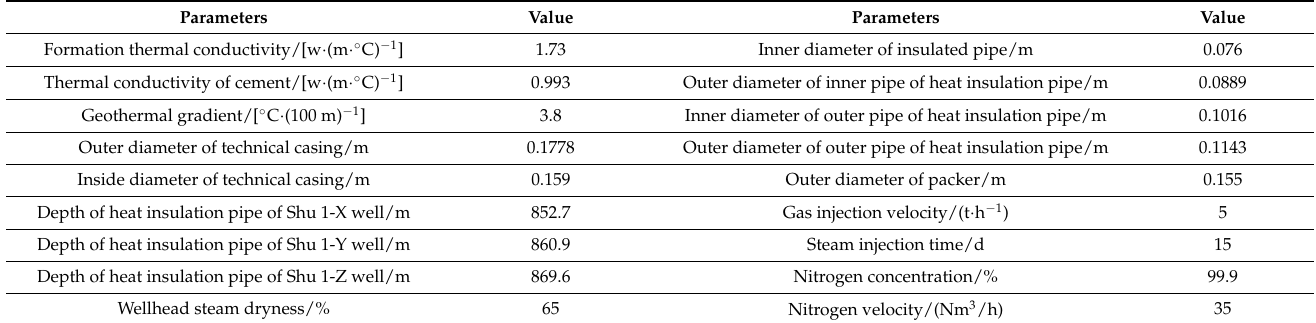
Table 3. Basic data for on-site implementation of nitrogen insulation .